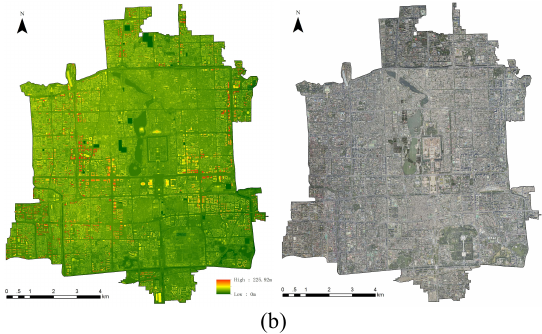
Figure 6. DSM and TDOM of 2015 and 2017. (a) DSM and TDOM of 2015, (b) DSM and TDOM of 2017 Because of the seasonal difference, tree masks were extracted as the pseudo-changes filter. 3-level segmentation and tree extraction of both TDOM based on Maximum Likeness Classifier (MLC) were carried out to reduce the change errors caused by the crown influence. By visual interpretation, the building height and area thresholds are set as 1.2 m and 5005 m 2 , respectively. The DSM difference result and the tree masks extracted from TDOM are shown in Figure 7 (a) and Figure 7(b). The filtered result and visually extracted changes of the Dongcheng Distrct are shown in Figure 7 (c) and Figure 7 (d).